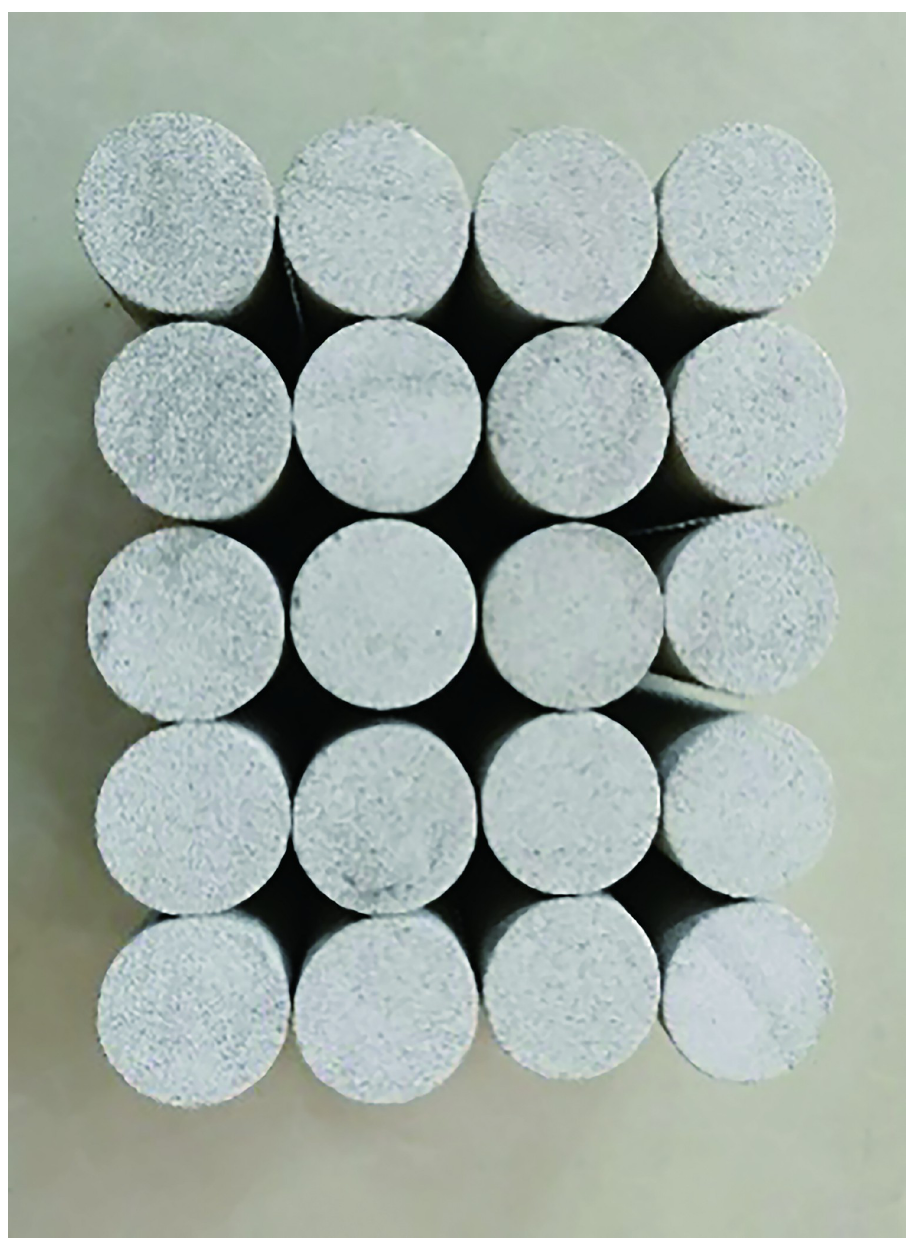
Fig 1. White sandstone specimens.